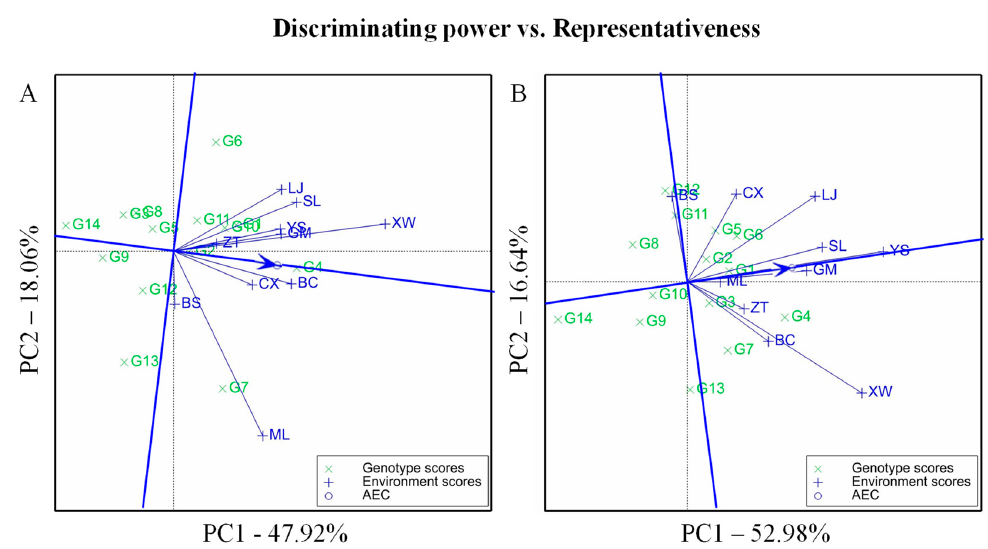
Figure 4. GGE biplot for the evaluation of the relationships among the 10 test environments. Envi- ronmental vectors having smaller angles are closely related. Environments having longer vectors are discriminating: ( A ) GGE biplot in 2020; ( B ) GGE biplot in 2021. See genotype and environment codes in Tables 1 and 2, respectively.